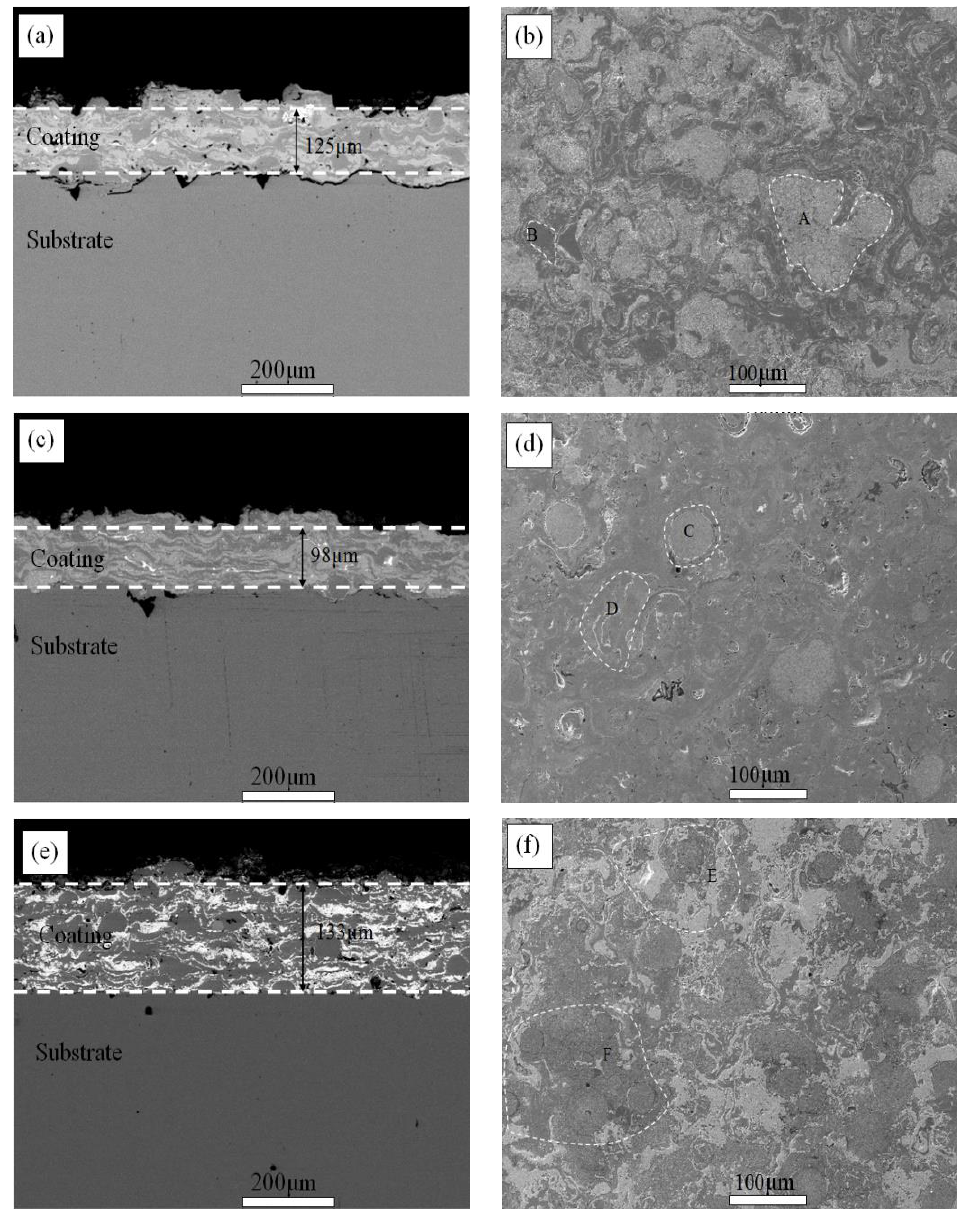
Figure 3. Microstructure of composite ceramic coatings, ( a , b ) Ni60, ( c , d ) Ni60T, ( e , f ) Ni60TW.